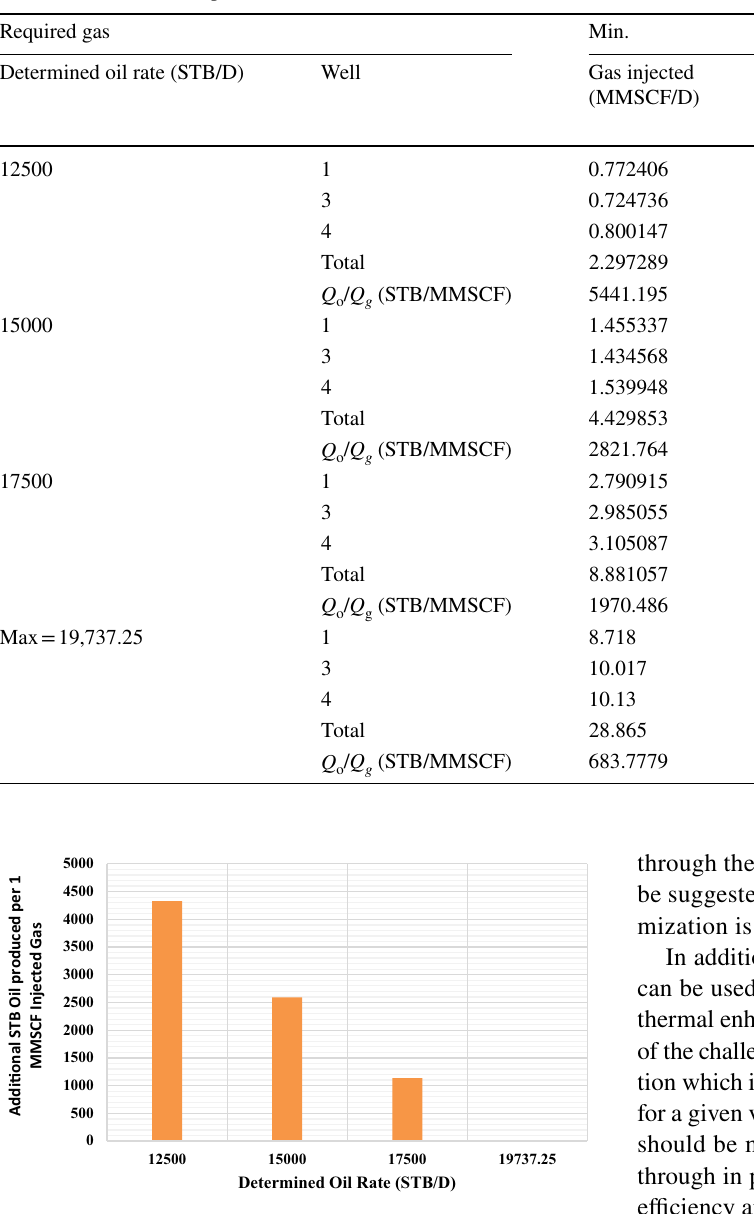
Fig. 7 Surplus oil rate produced in the optimal scenario (the mini- mum required gas) compared to the worst possible scenario (the max- imum required